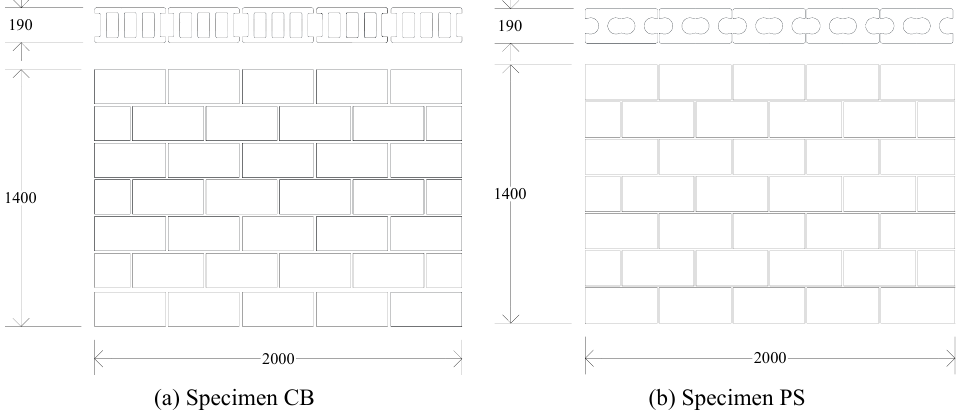
Figure 4. Details of typical and proposed concrete block wall specimens (unit: mm).